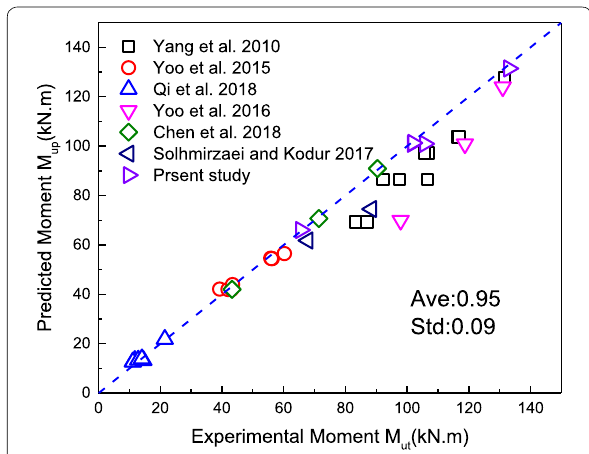
Fig. 23 Comparison of experimental and predicted ultimate